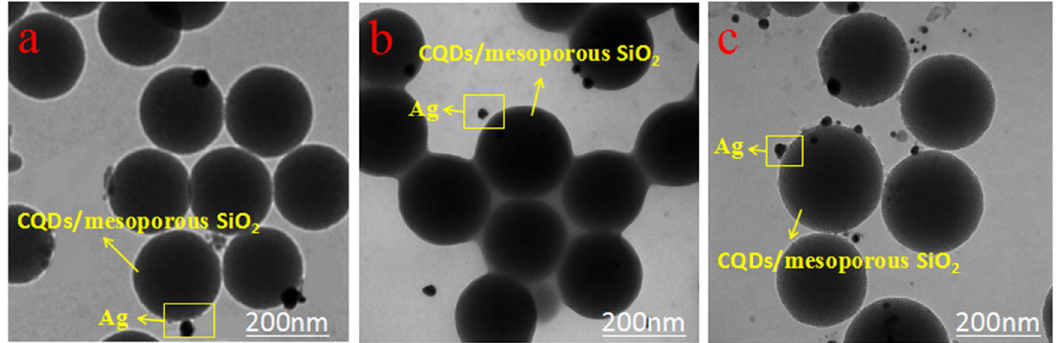
Figure 4: TEM images of CQDs/mesoporous SiO 2 /Ag NPs composites in photochemical reactor for di ff erent UV irradiating time: ( a ) 1 h, ( b ) 2 h, and ( c ) 3